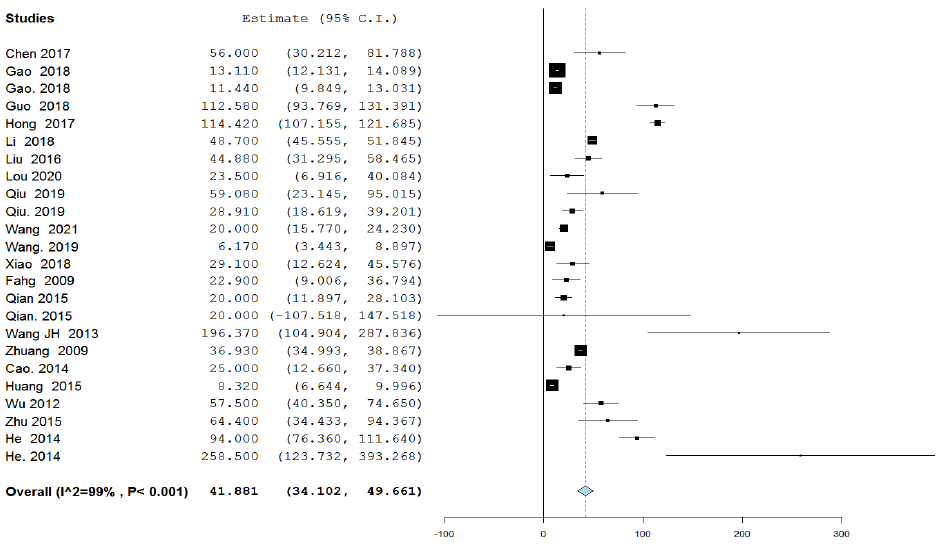
Figure 3. A forest plot of the amount of intraprocedural blood loss in mL.